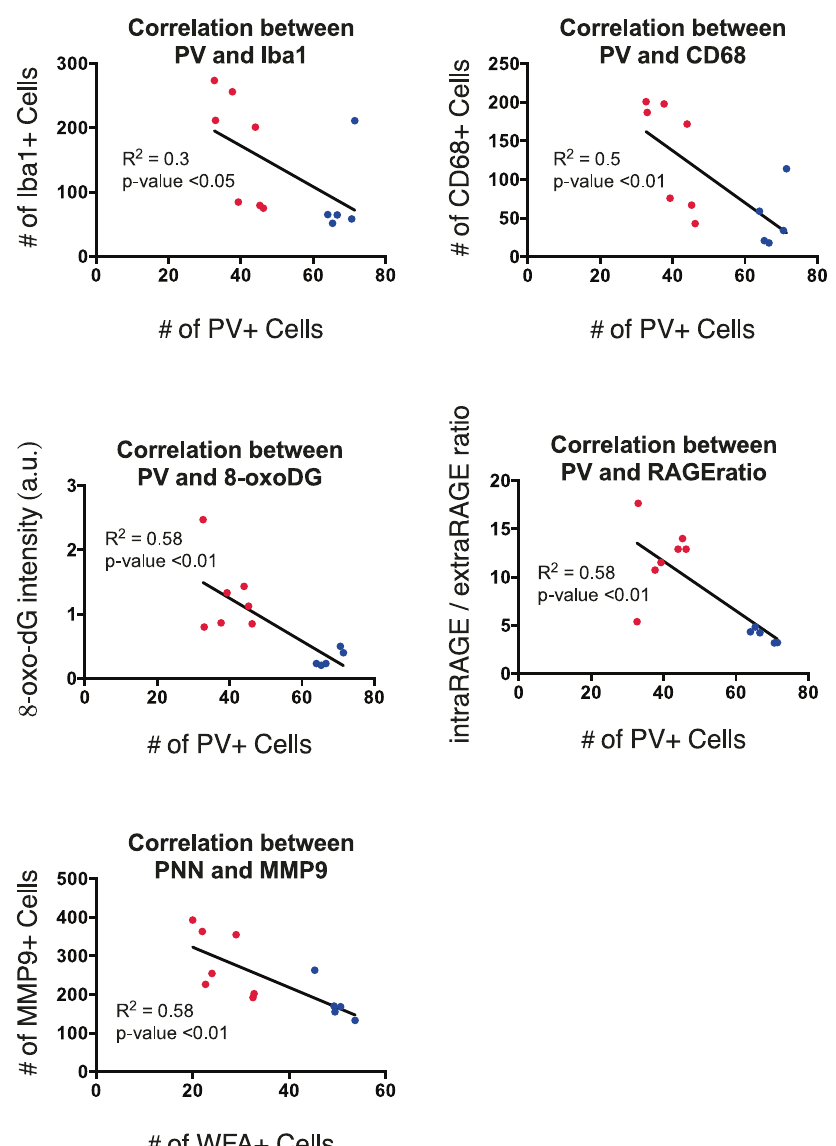
Fig. 4 Negative correlation between PV and markers of oxidative stress/microglia activation, as well as between PNN and MMP9 at P35. Negative correlation between PV + cells and Iba1 cell count in IUGR (red) and control (blue) group together ( N = 12; R 2 = 0.3, p < 0.05). Negative correlation between PV + cells and CD68 cell count in IUGR and control group together ( N = 12; R 2 = 0.5, p < 0.01). Negative correlation between PV + cells and 8-oxo-dG intensity in IUGR and control group together ( N = 12; R 2 = 0.58, p < 0.01). Negative correlation between PV + cells and RAGE ratio in IUGR and control group together ( N = 12; R 2 = 0.58, p < 0.01). Negative correlation between WFA + cells and MMP9 + cells in IUGR and control group together ( N = 12; R 2 = 0.58, p < 0.01). * p = 0.05, ** p <